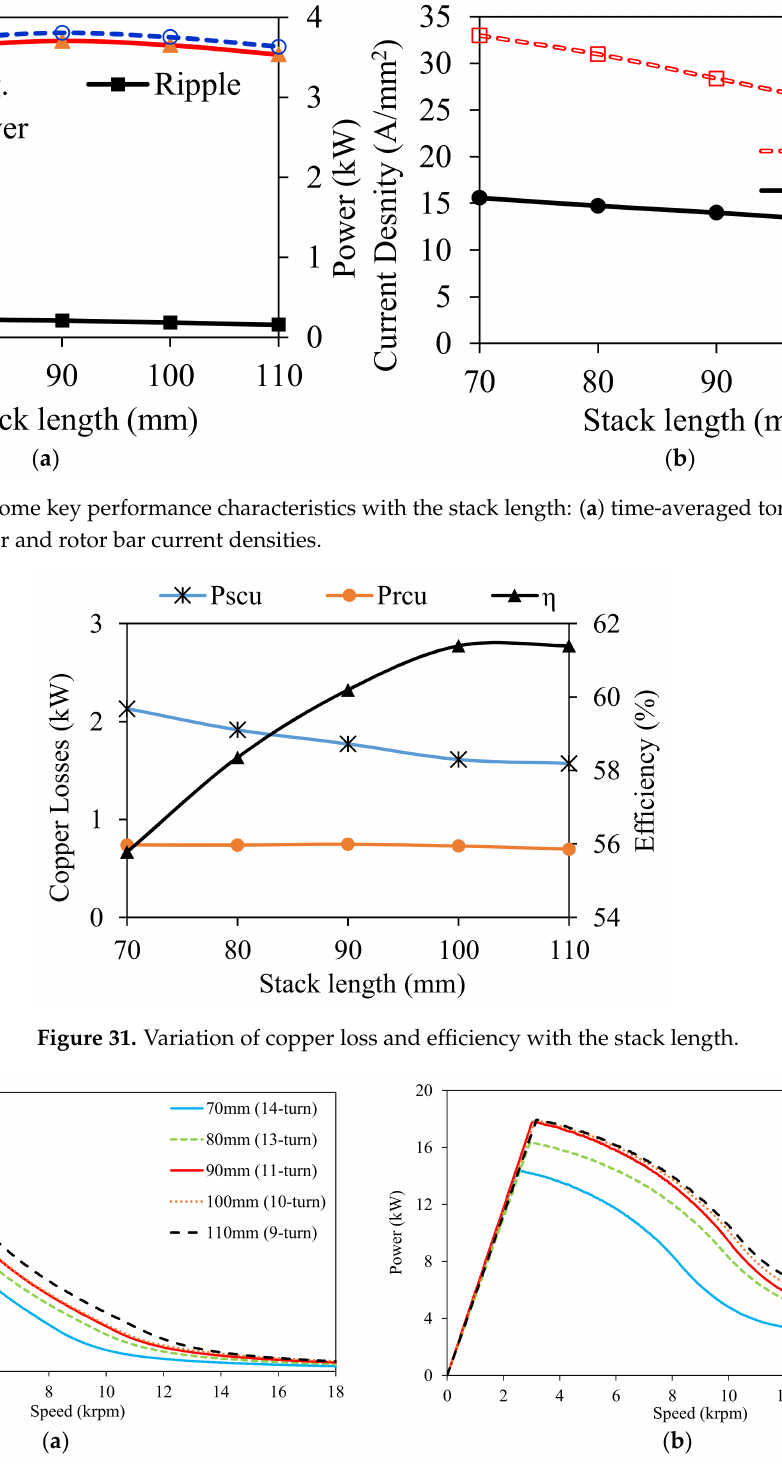
Figure 32. Flux-weakening characteristics of 36S/38R/12P AIM for various stack lengths and number of turns. ( a ) Torque- speed curve; ( b ) power-speed